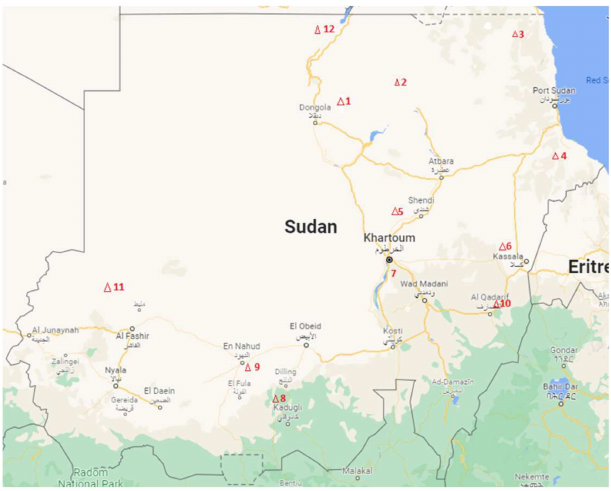
Figure 10. Selected sites used for case study.